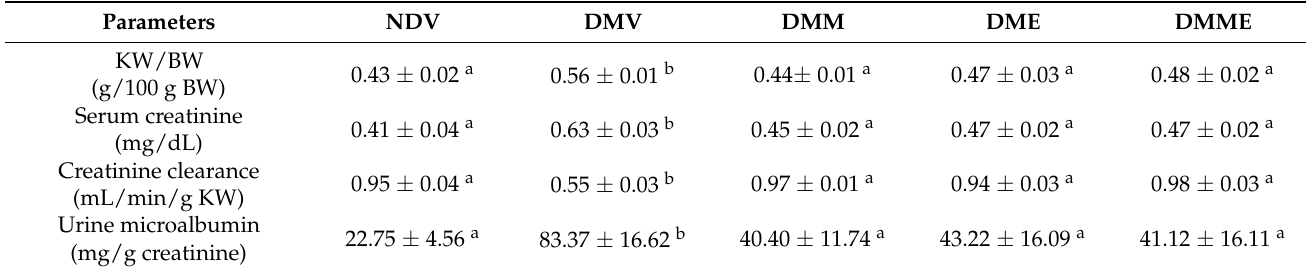
Table 2. Effects of purple rice husk extract (PRHE) and metformin on renal function.